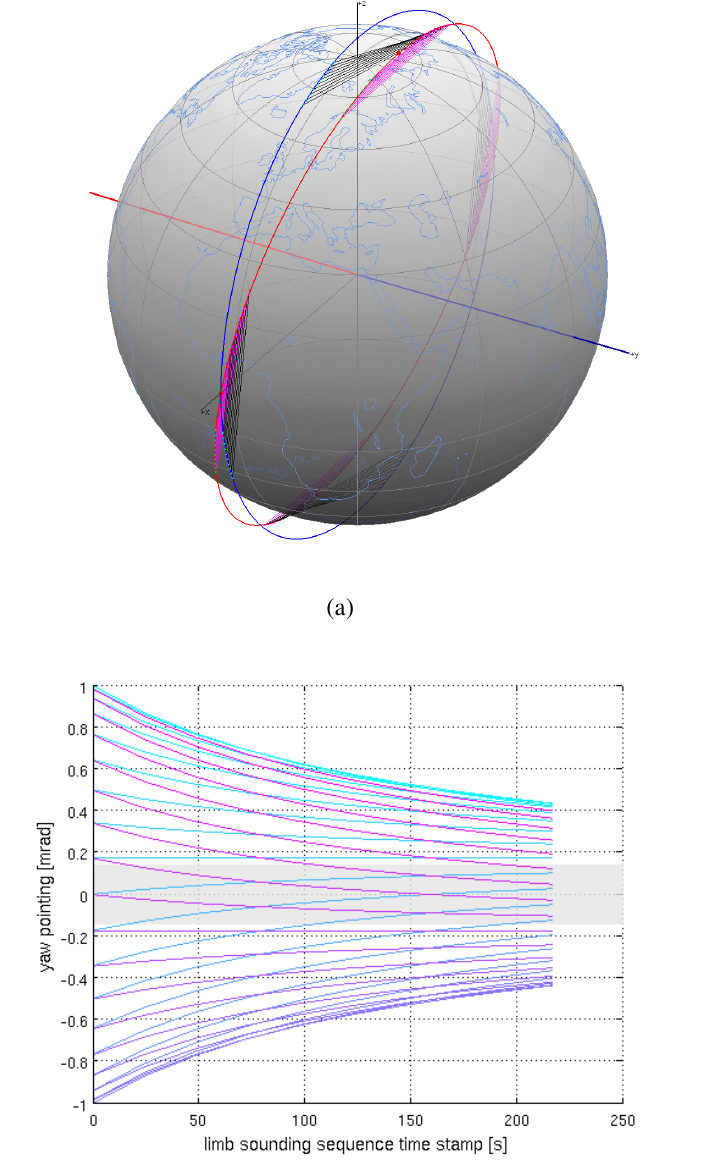
Figure 11. ( a ) Required yaw pointing when primary spacecraft (PSC) and retroreflector (RSC) are in different orbital planes, for the exaggerated case of a 10 degree inclination difference for illustration (the specified tolerance in reality is 0.01 degrees). The PSC is on a prograde orbit with 80 degrees inclination (red), the RSC are on a retrograde polar orbit with 270 degrees inclination (blue). The red and blue lines represent the respective normal vectors. The thick red dot shows the tangent point, purple lines are sounding paths in the ideal configuration of a single orbital plane, black lines represent real occultations. ( b ) Required yaw tracking during a typical measurement sequence for tangent points at different positions around an orbit (colours), and orbital planes characterized by a 0.01 degrees divergence in RAAN. The shaded area indicates the field-of-view of the limb telescope within which no yaw pointing is required during the